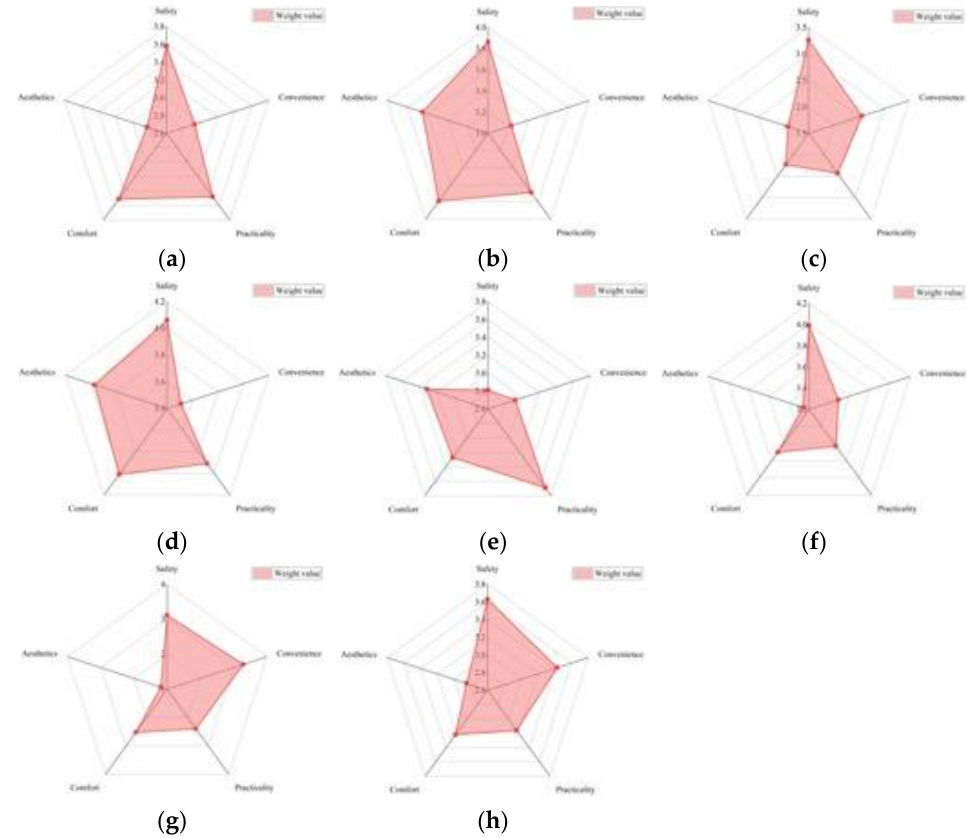
Figure 18. Distribution of evaluation results of the transfer environment criterion layer at sample stations: ( a ) Century Avenue Station; ( b ) People's Square Station; ( c ) Shanghai Railway Station; ( d ) Hanzhong Road Station; ( e ) Xujiahui Station; ( f ) East Nanjing Road Station; ( g ) Jiangsu Road Station; ( h ) Laoximen Station.